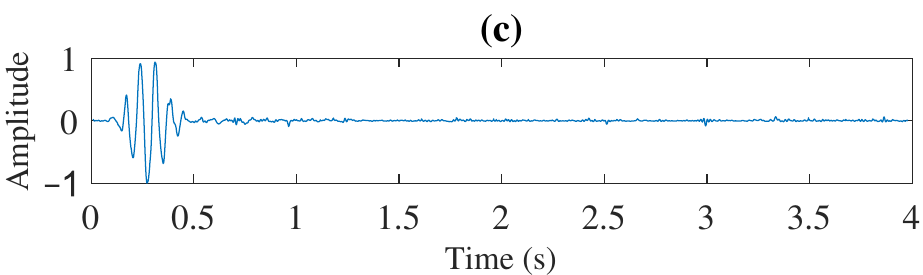
Figure A1. Single trace SNR enhancement (SNR of received data is − 8 dB). ( a ) Original trace. ( b ) Reconstructed trace after MLSE. ( c ) Reconstructed trace after SNR enhancement.